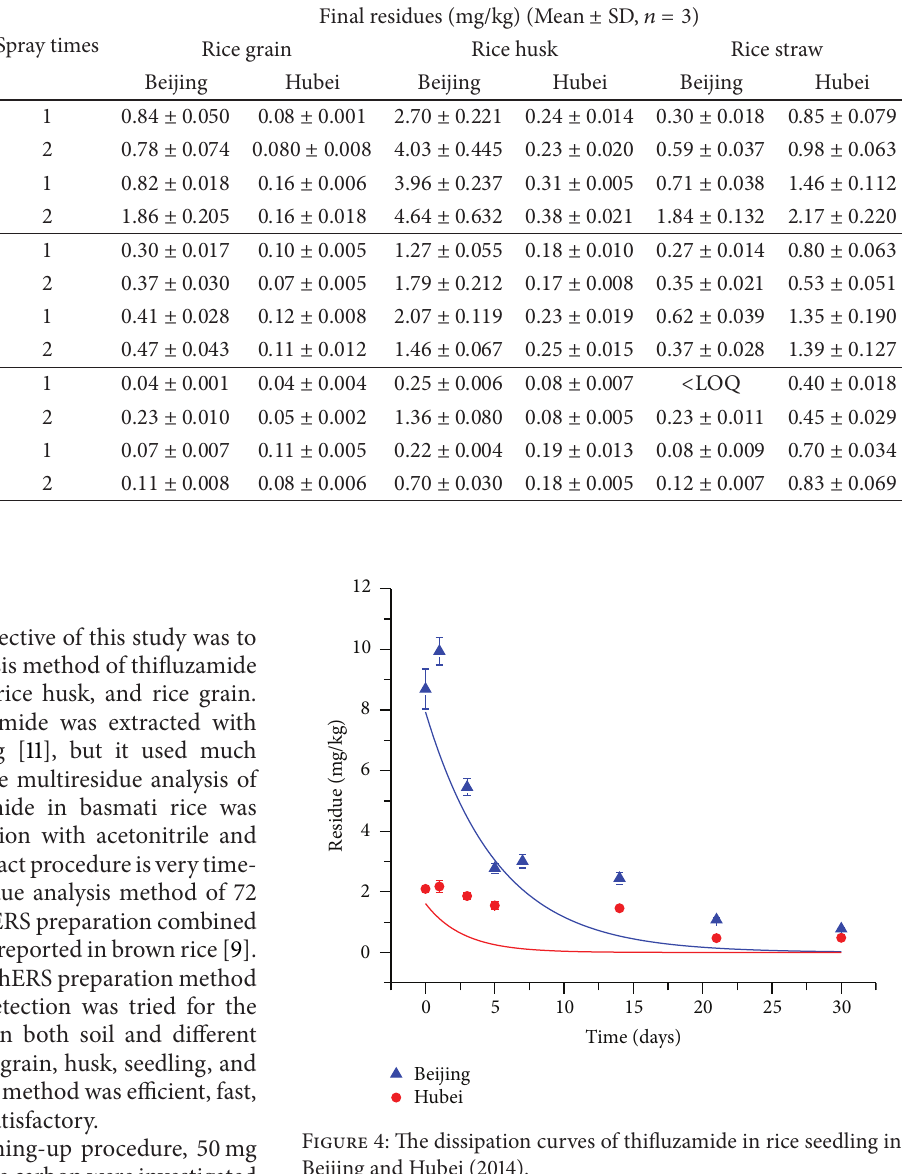
Table 4: Final residues of thifluzamide in rice plants (2014).